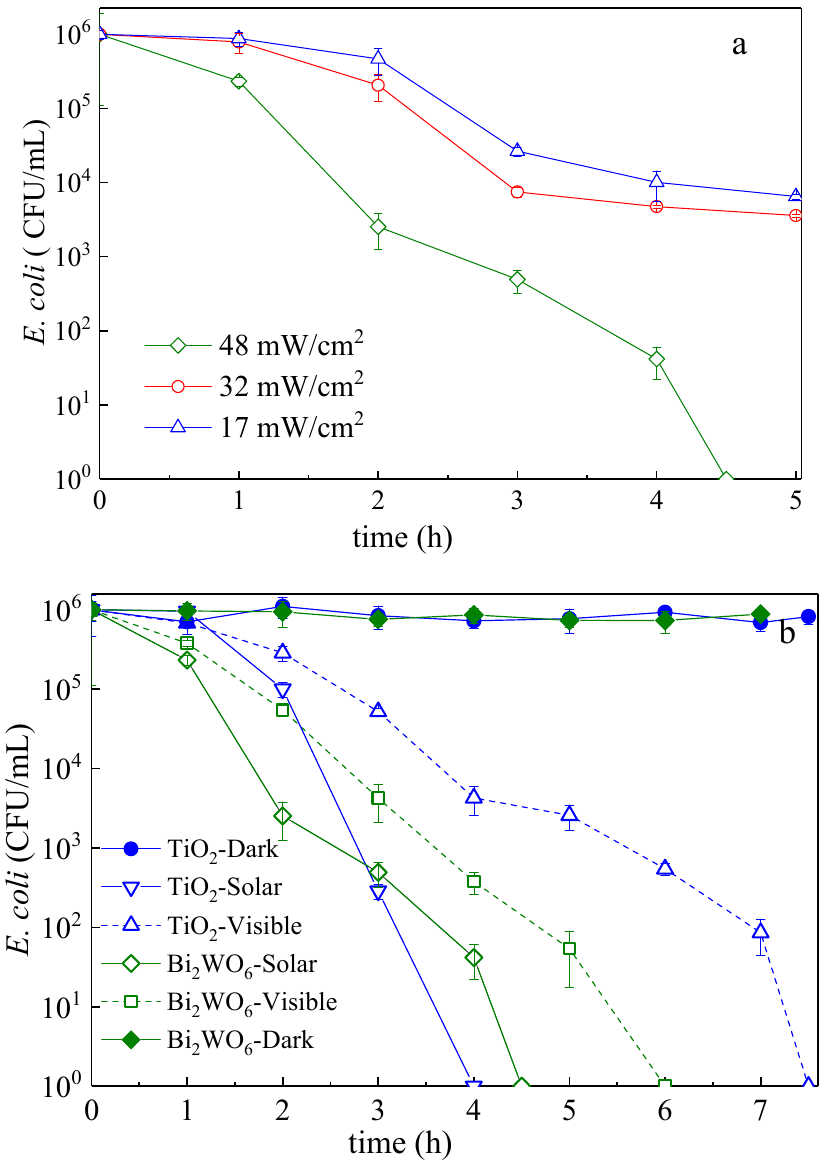
Figure 8. Effect of light irradiance and composition on inactivation kinetics. ( a ) E. coli inactivation on Bi 2 WO 6 (200 °C for 24 h) under different solar light irradiation intensities. ( b ) E. coli inactivation mediated by Bi 2 WO 6 (200 o C for 24 h) and TiO 2 under low intensity solar simulated (48 mW/cm 2 ) and visible light (38 mW/cm 2 ). Experimental conditions: (Catalyst) 0 = 0.2 g/L and (bacteria) 0 = 2 × 10 6 CFU/mL.